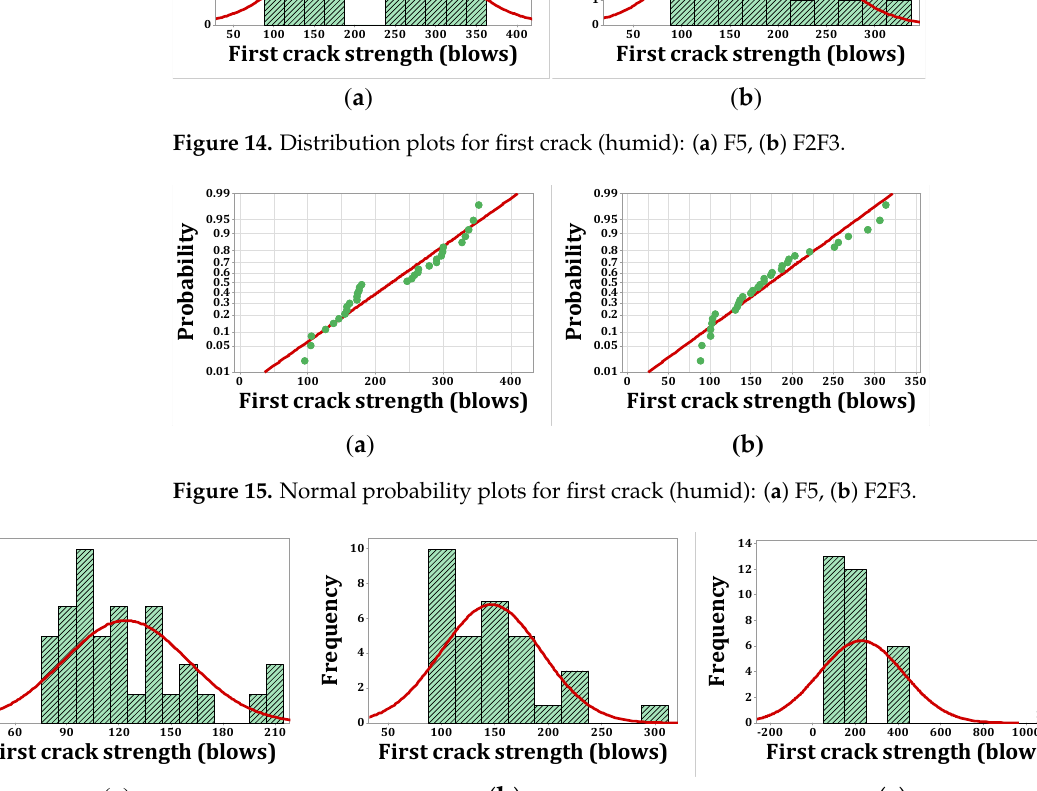
Figure 16. Distribution plots for first crack (dry): ( a ) R, ( b ) F2, ( c ) F3.